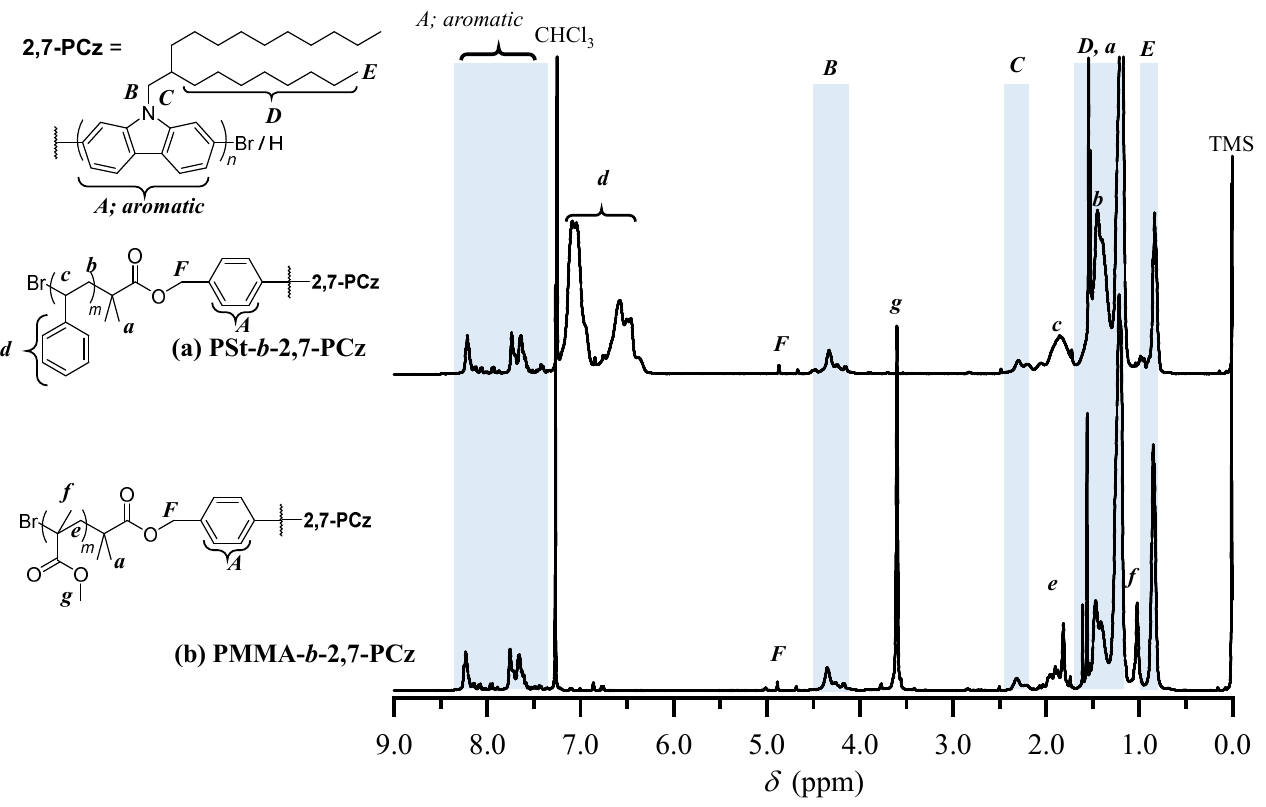
Figure 12. 1 H NMR spectra of ( a ) PSt- b -2,7-PCz and ( b ) PMMA- b -2,7-PCz (400 MHz, CDCl 3 ).